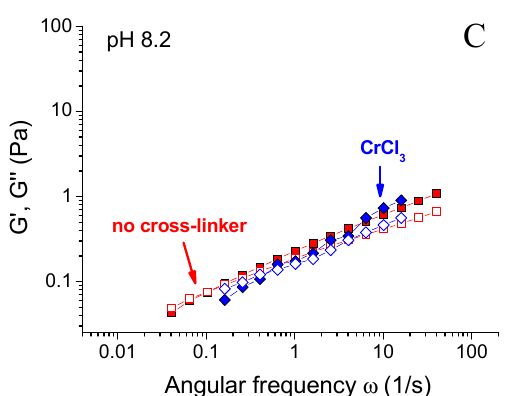
Figure 4. Frequency dependences of storage G ʹ ( fi lled symbols) and loss G” (open symbols) moduli for 0.1 wt % xanthan aqueous solutions in the absence of the cross-linker (squares) and in the presence of 0.017 wt % CrCl 3 corresponding to the molar ratio [CrCl 3 ] / [xanthan monomer units] = 1 (other symbols) prepared at pH 1.5 ( A ), 6.3 ( B ) and 8.2 ( C ) at 20 °C.